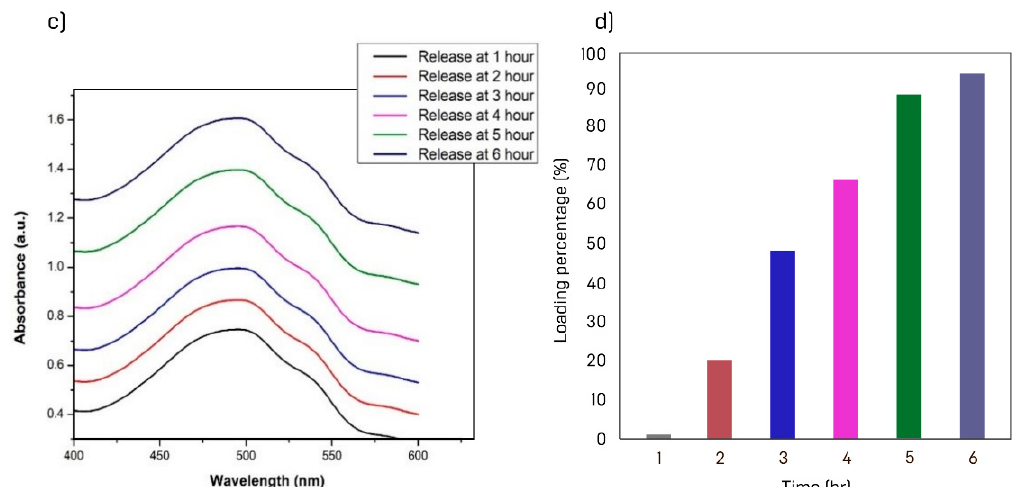
Figure 9. ( a ) Change in UV absorbance with loading time; ( b ) bar graph shows the decrease in loading capacity with time; ( c ) change in UV absorbance with time during desorption; ( d ) bar graph of desorption with time.